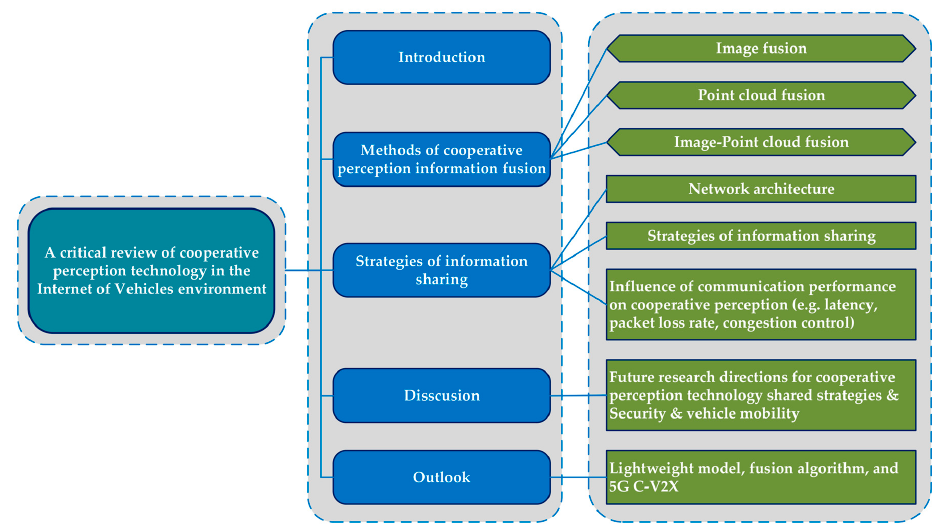
Figure 1. An overall diagram of the critical review on cooperative perception in the Internet of vehicles